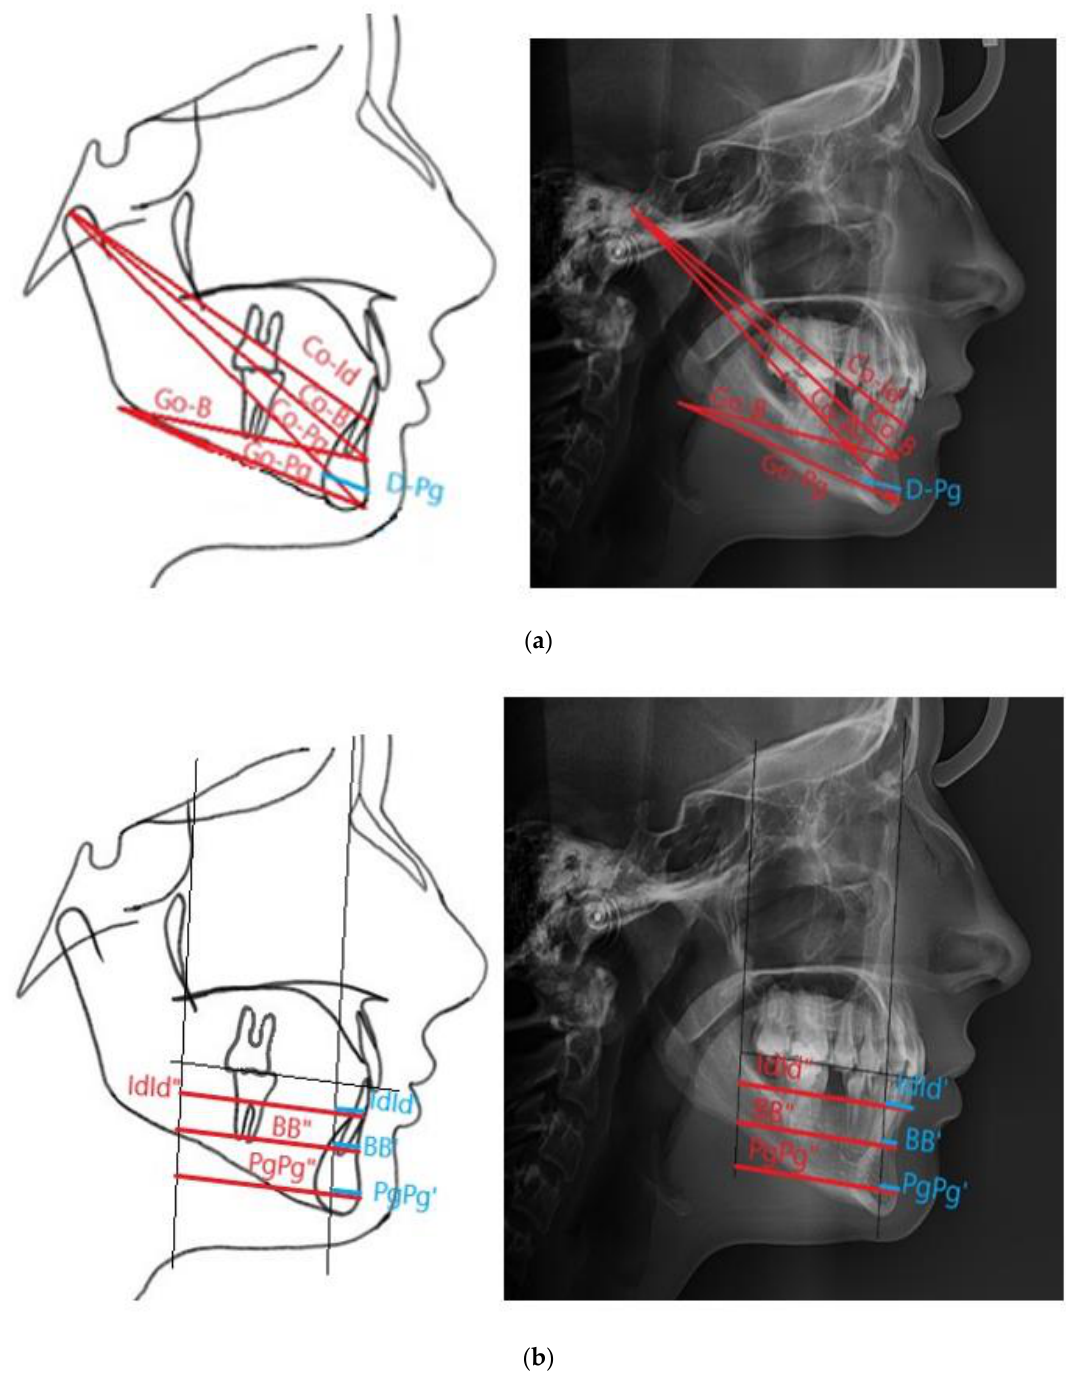
Figure 2. Linear measurements of the mandible used in the study. ( a ) shows the distance of selected points from the top of the condylar process and the angle of the mandible; ( b ) shows the distance of the points Id, B and Pg from the lines PA and PM.